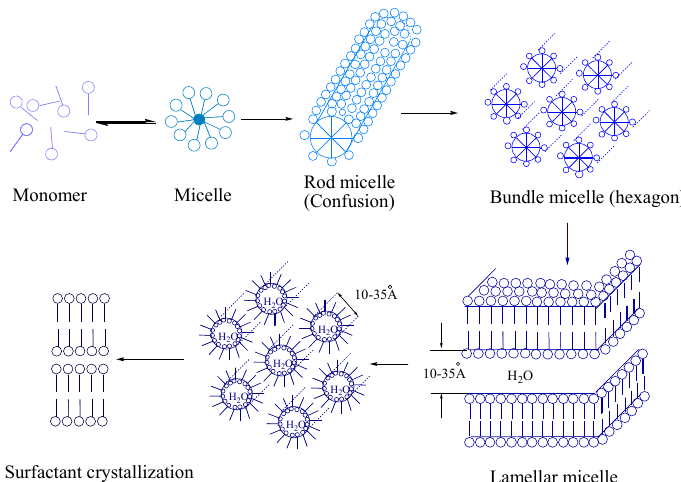
Figure 1. Structure formation in surfactant solution.